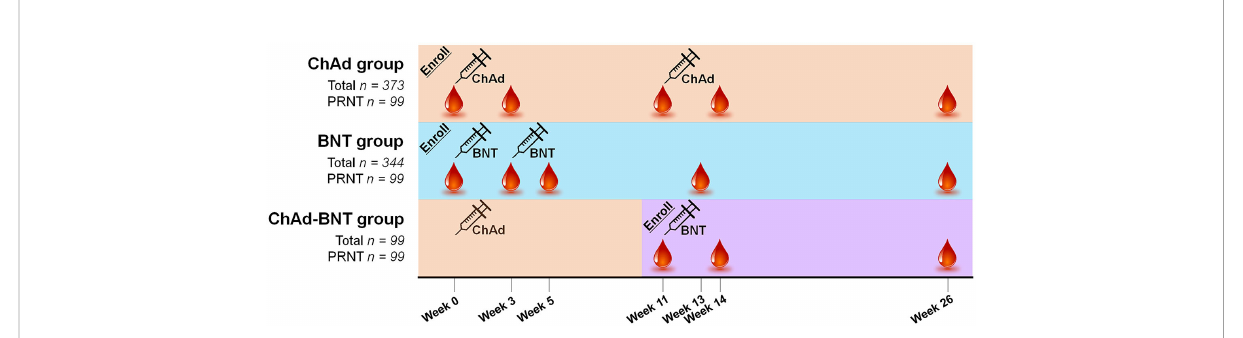
FIGURE 1 Vaccination schedule and sample acquisition timeline for each group. ChAd, AZD1222 ChAdOx1 vaccine; BNT, BNT162b2 vaccine; PRNT, plaque-reduction neutralizing test.